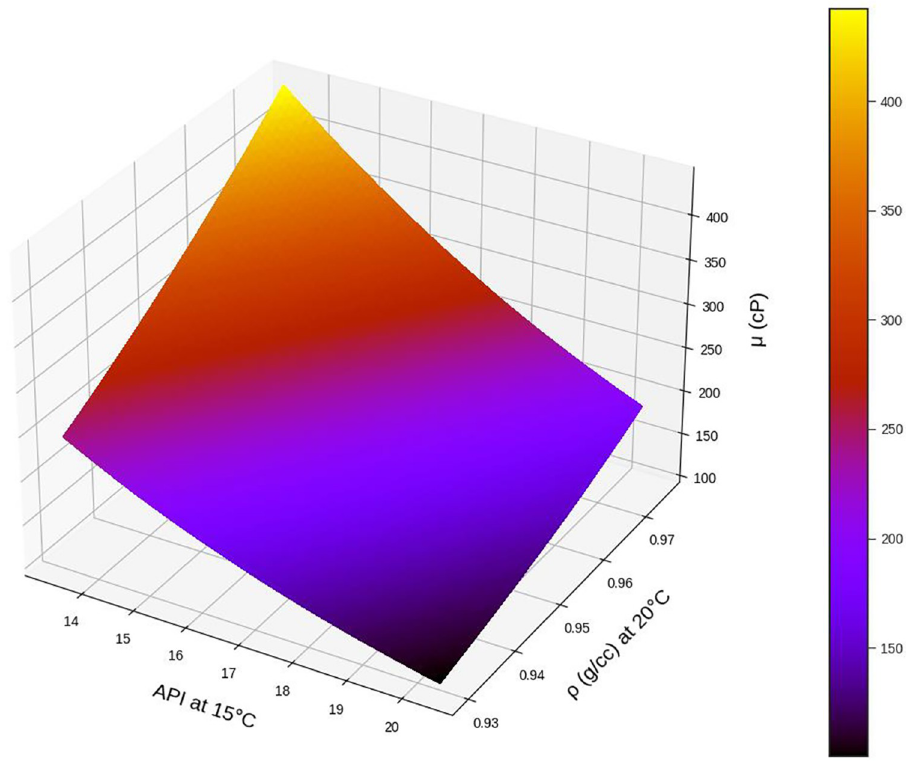
Fig 8. Effect of API and ρ (g/cc) on the output. %C4 = 0.35, %C5 = 1.62, %C6 = 3.21, %C7+ = 94.81, MWC7+ = 338.41, SGC7+ = 0.95, T (˚C) = 30.